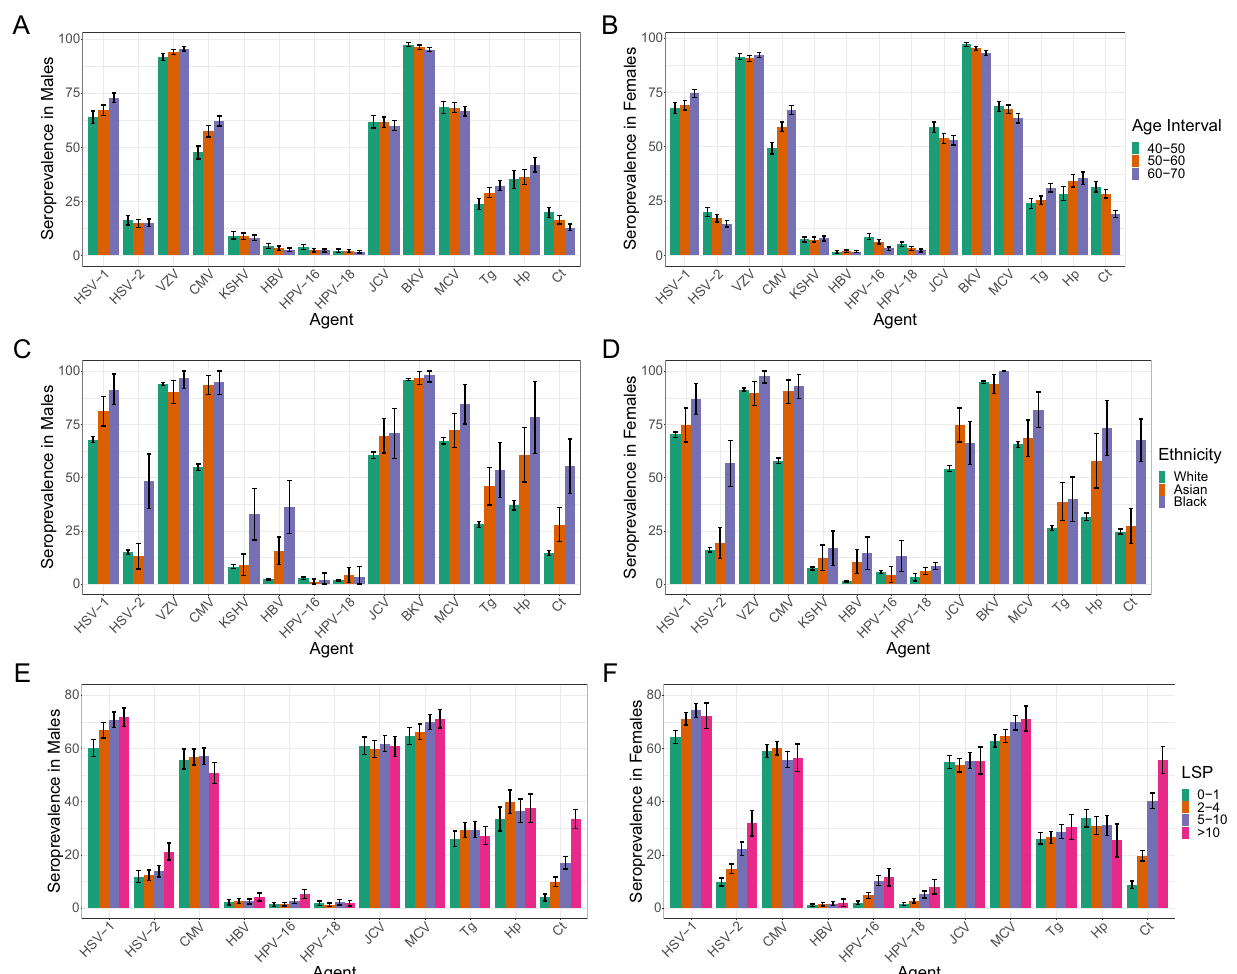
Fig. 1 Crude seroprevalence estimates and 95% con fi dence intervals for multiple infectious agents in 9695 biologically independent UK Biobank participants strati fi ed by sex and age (A for males and B for females), self-reported ethnicity (C for males and D for females) and LSP (E for males and F for females). Precise numbers of individuals in each category are provided in Supplementary Tables 9 – 11. The infectious agents represented are those with signi fi cant ( P < 0.01) evidence of differences based on crude estimates when testing for association with either males or females alone, or combined with each of age, self-reported ethnicity and LSP where suf fi cient numbers of individuals were available in each group for models to converge. Evidence of interaction with sex was only observed for VZV ( P = 0.01) and HPV-16 ( P = 0.04) with age, and HSV-2 ( P = 7.5 × 10 − 5 ) and HPV-18 ( P = 0.01) with LSP. All P -values reported were from the likelihood ratio test with no adjustment for multiple testing. Table 3 Crude seroprevalence and adjusted odds ratios for HBV, HIV-1 and Ct in men reporting same sex intercourse in males. Infectious agent Ever had same sex intercourse